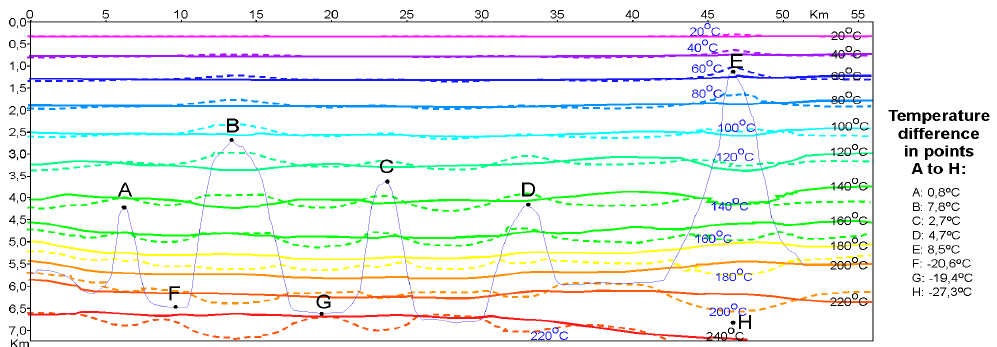
Figure 19. Calculated present-day temperature for models with salt and without salt. The temperature isotherm curves for the model with salt (stippled lines and blue temperature numbers), and the model without salt (continuous lines, black temperature numbers). In the salt model points A–D show higher temperatures than in the model without salt. Points F–H show lower temperatures in the salt model.